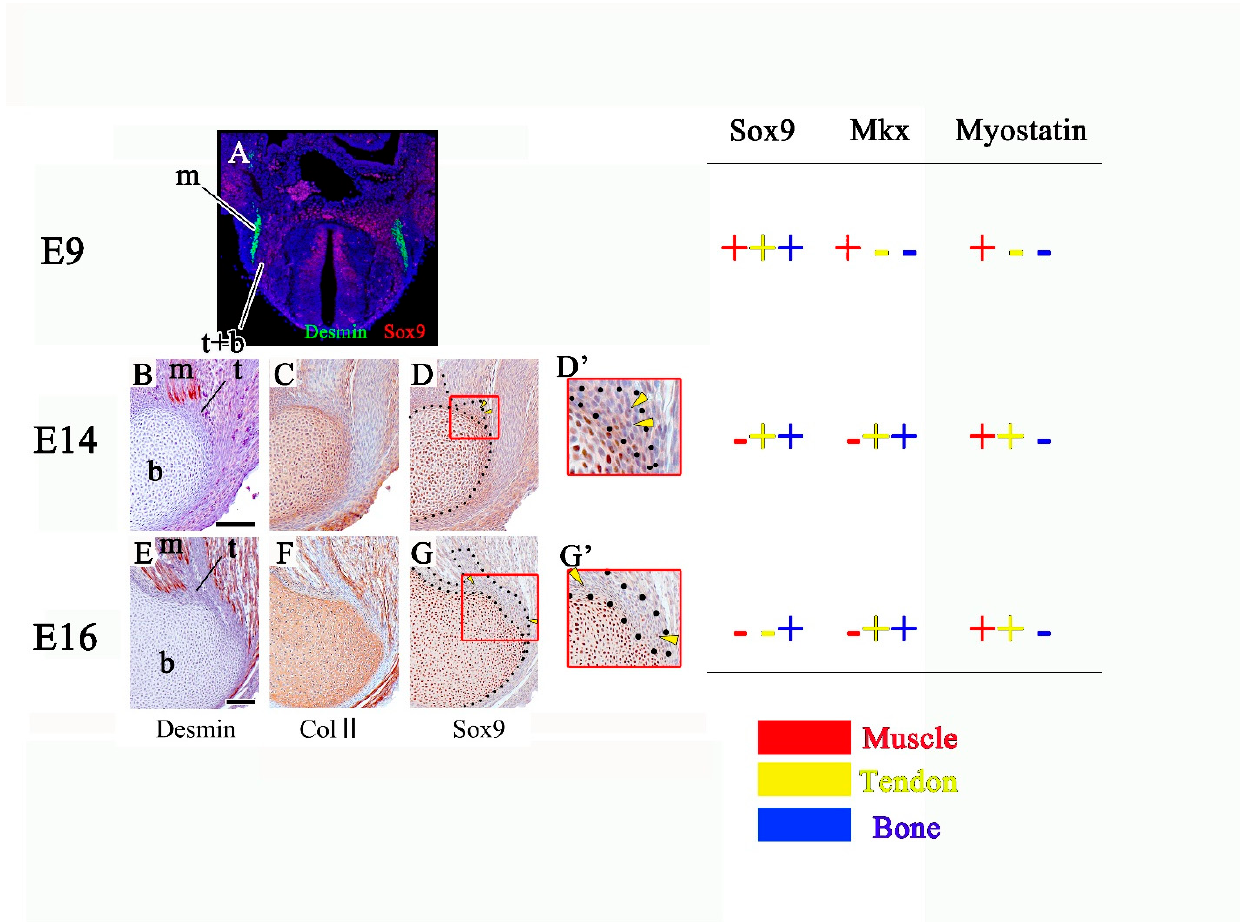
Figure 3. Mkx, myostatin and Sox9 are expressed during the musculoskeletal development. ( A ) Transverse section of embryo at E9. ( B – G ) Sagittal sections of attachment site of the triceps brachii muscle at E14 and 16. ( D’ , G’ ) is the high magnification view of ( D , G ). m: future muscle, t: future tendon, b: future bone. (Scale bar:100 μ m)